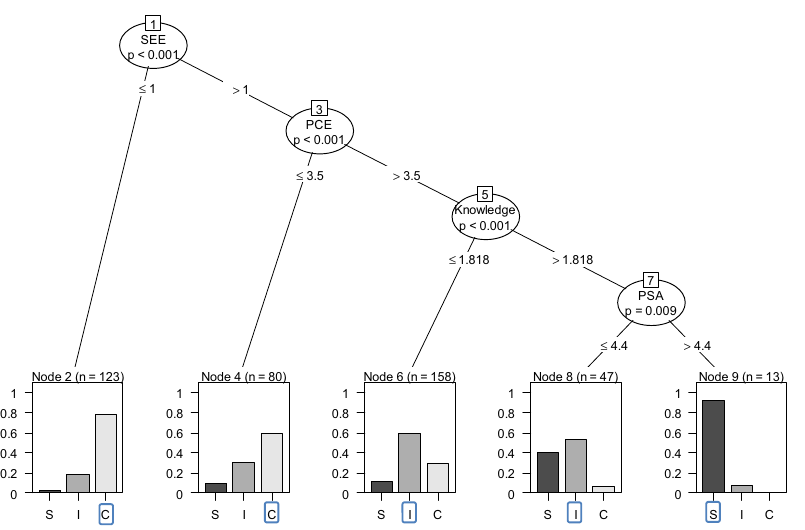
Fig. 1 Classification Tree for SR fund, INT, and CONV investors The classification tree method identifies the following variables being essential factors for investor group differences concerning investment decisions regarding SR funds: PSA pro-social attitudes, PCE perceived consumer effectiveness, SEE subjective rating of the importance of considerations of social, ethical, and environmental criteria in the investment process and Knowledge (mean value of knowledge concerning different SR terms). S: SR fund investors; I: INT investors; C: